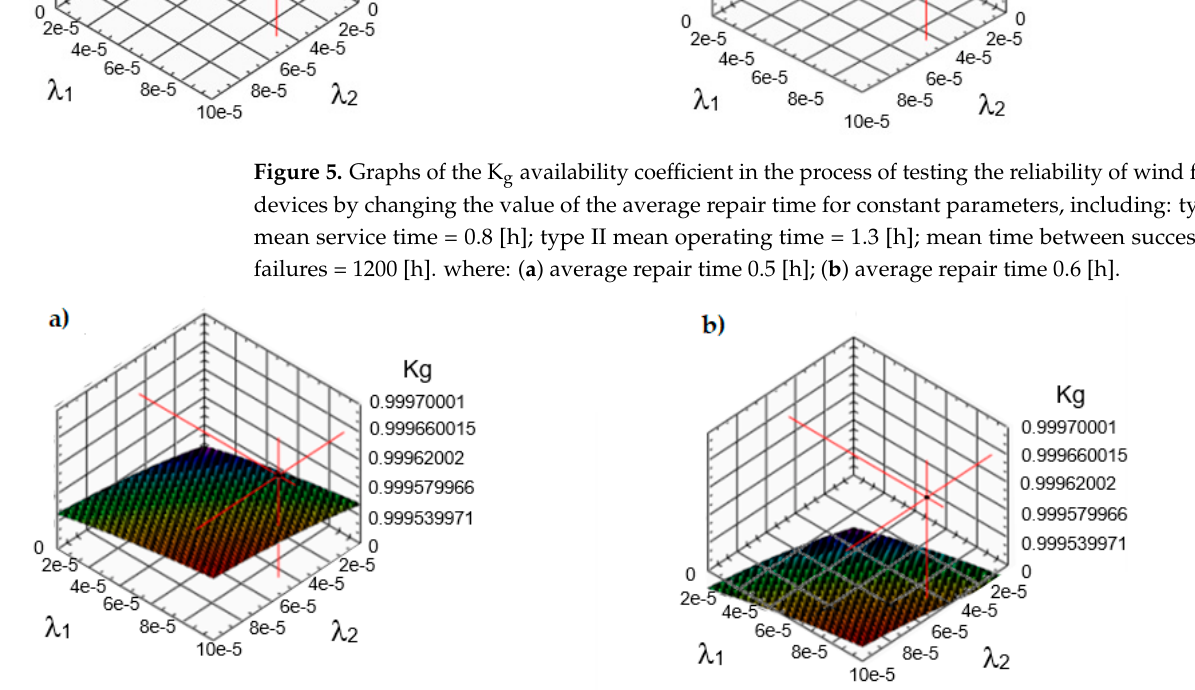
Figure 6. Graphs of the K g availability coefficient in the process of testing the reliability of wind farm devices by changing the value of the average repair time for constant parameters, including: type I mean service time = 0.8 [h]; type II mean operating time = 1.3 [h]; mean time between successive failures = 1200 [h], where: ( a ) mean repair time 0.7 [h]; ( b ) average repair time 0.8 [h].